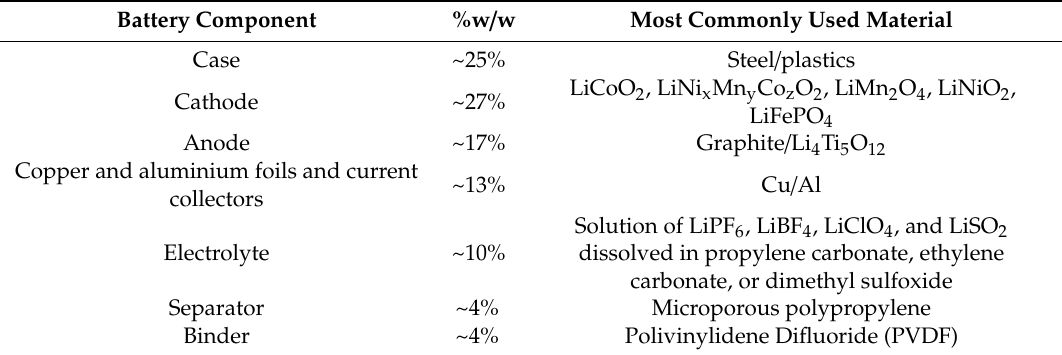
Table 1. Lithium-Ion Battery (LiB) Constructive Components and